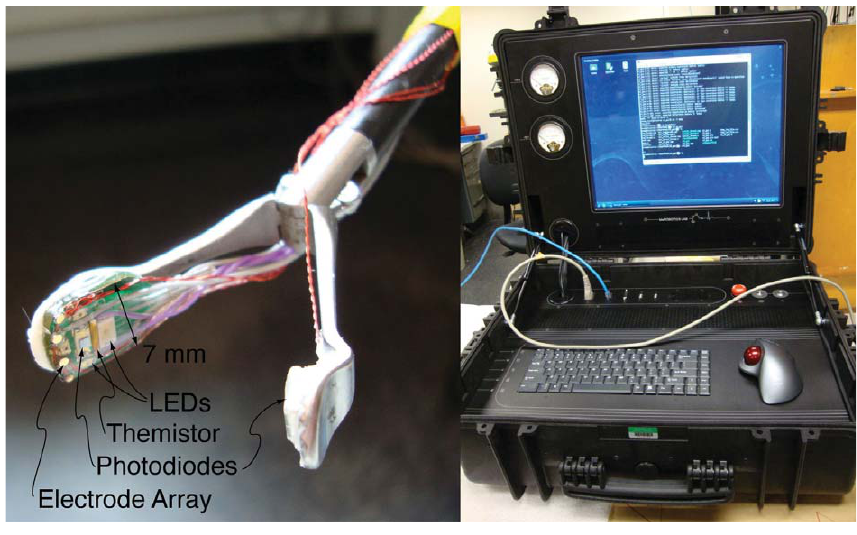
Fig. 5. (Left) A photograph of the sensor heads mounted to the grasper. (Right) A photograph of the control box running a real-time enabled version of Linux.